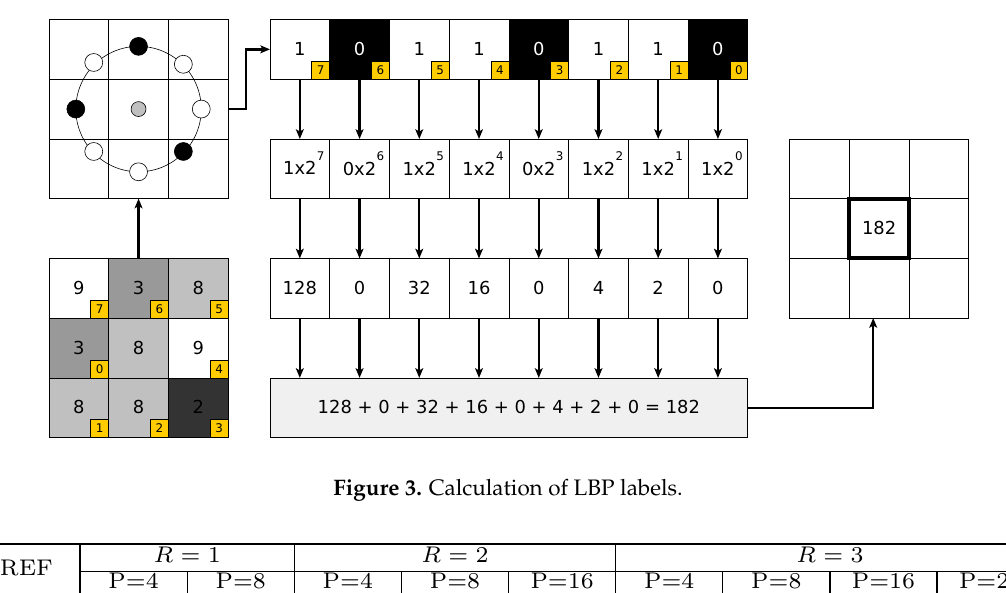
Figure 3. Calculation of LBP labels.